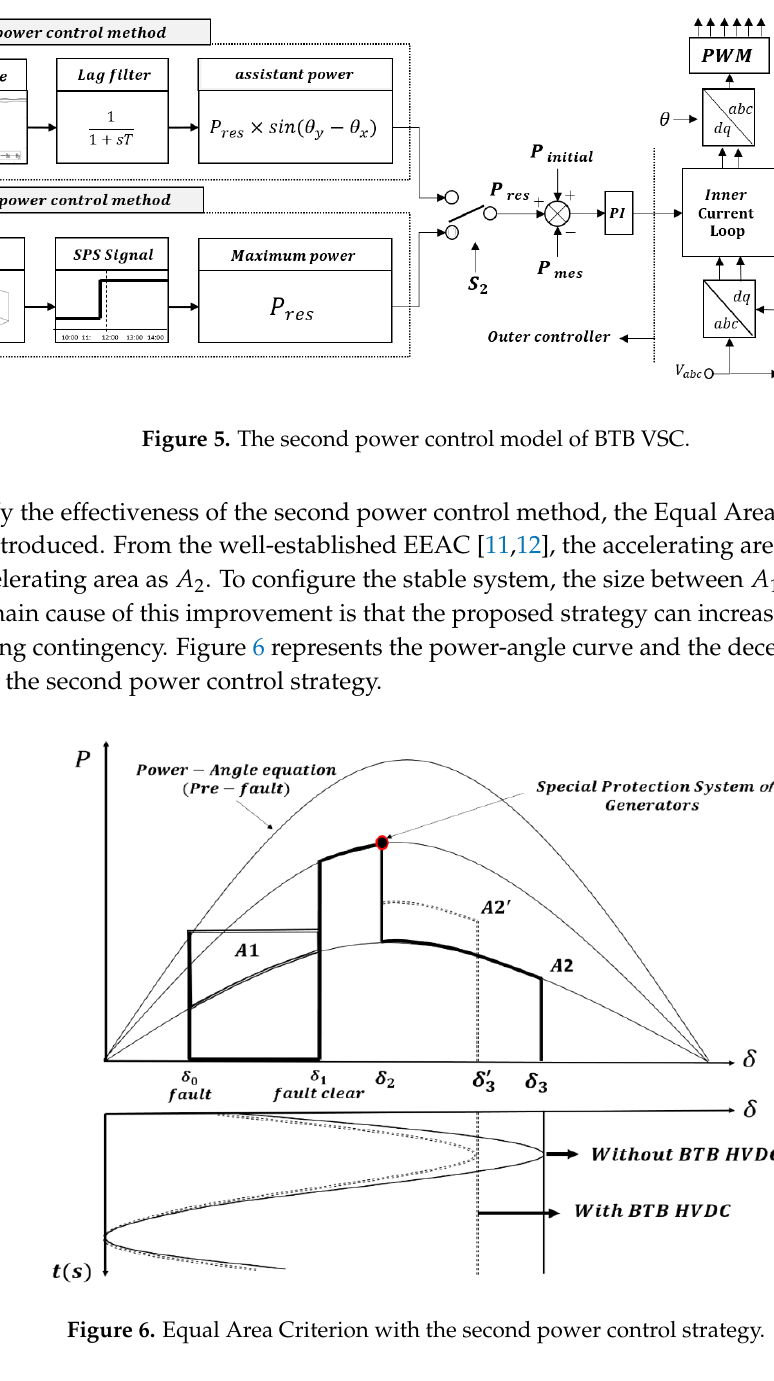
( b ) Figure 4. ( a ) Capability curve of BTB VSC and ( b ) determination process of 𝑃 𝑟𝑒𝑠 value. 3 . 2 . The Second Power Control Model of BTB VSC Each country, whether it has a different Special Protection System (SPS), as the generators tripping schemes are generally called, commonly commands specific generators to be tripped to balance the grid power. This process is generally adopted by grid operators, and to prevent the fault spread, the SPS signal that commands each generator to be tripped is activated. Under an N-2 contingency, as the level of fault increases, more generator rejection has to be applied to sustain the grid stability. The common protocol of SPS is performed according to time domain simulation with major contingencies, and the stability margin is determined by the index of acceleration and the decelerating energy [11,12]. With the second power control strategy, the flexible operation of the generator tripping scheme